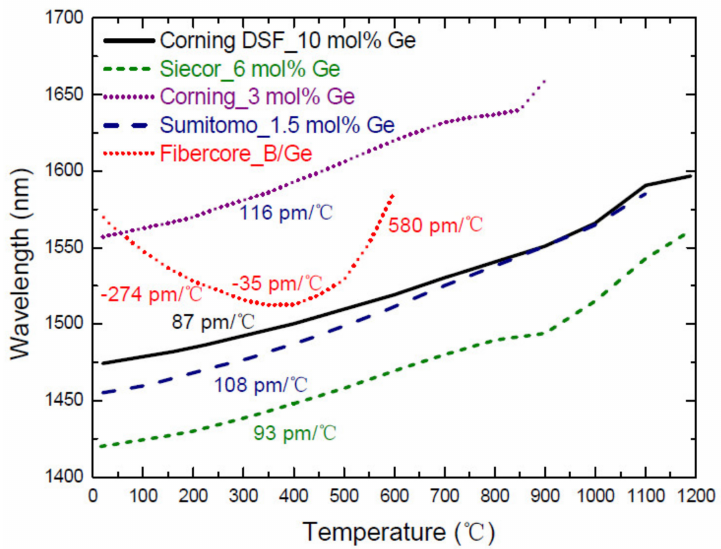
Figure 2. Thermal behavior of LPFGs arc-induced in Ge-doped fibers. Reprinted from